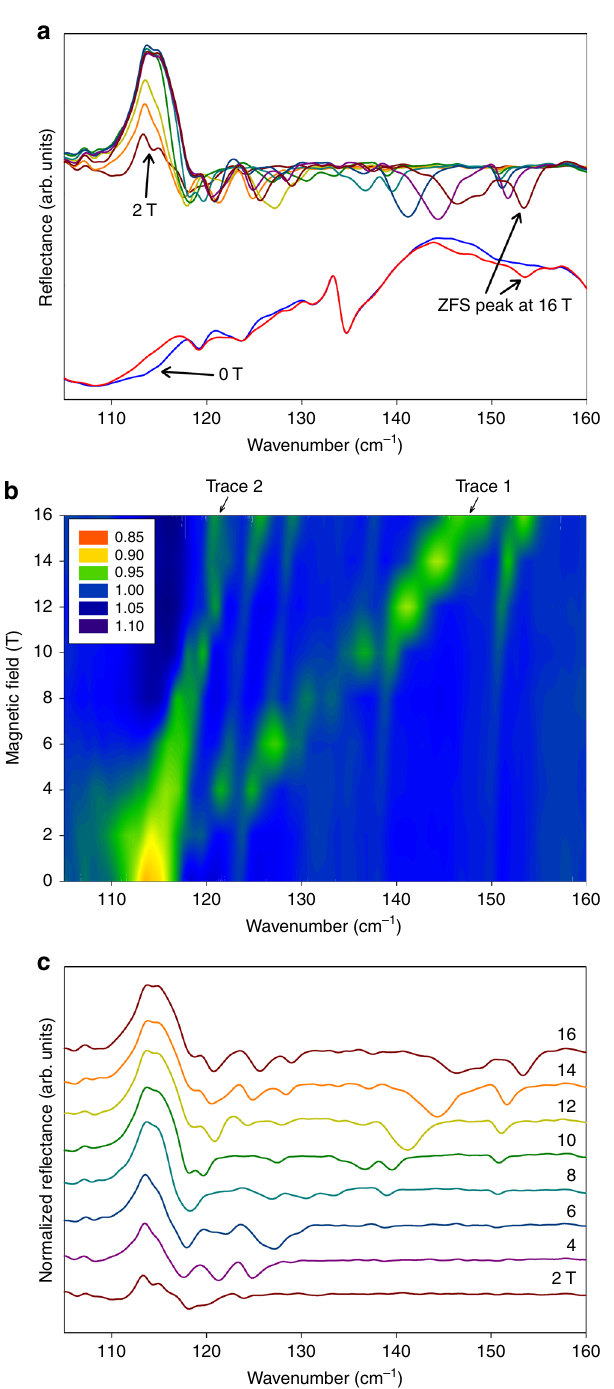
Fig. 6 Far-IR re fl ectance spectra of 1 - d 4 . a Re fl ectance spectra (bottom, 0 T-blue and 16 T-red) and normalized (by the 0 T) re fl ectance spectra (top) by a single crystal of 1- d 4 , in which the ZFS transition is more visible as it shifts with fi eld at 2, 4, 6, 8, 10, 12, 14 and 16 T. b Contour plot of the normalized re fl ectance spectra (by the average of all spectra) which shows the ZFS transitions and the magnetic features of spin – phonon coupled peaks. c Normalized re fl ectance spectra using data in